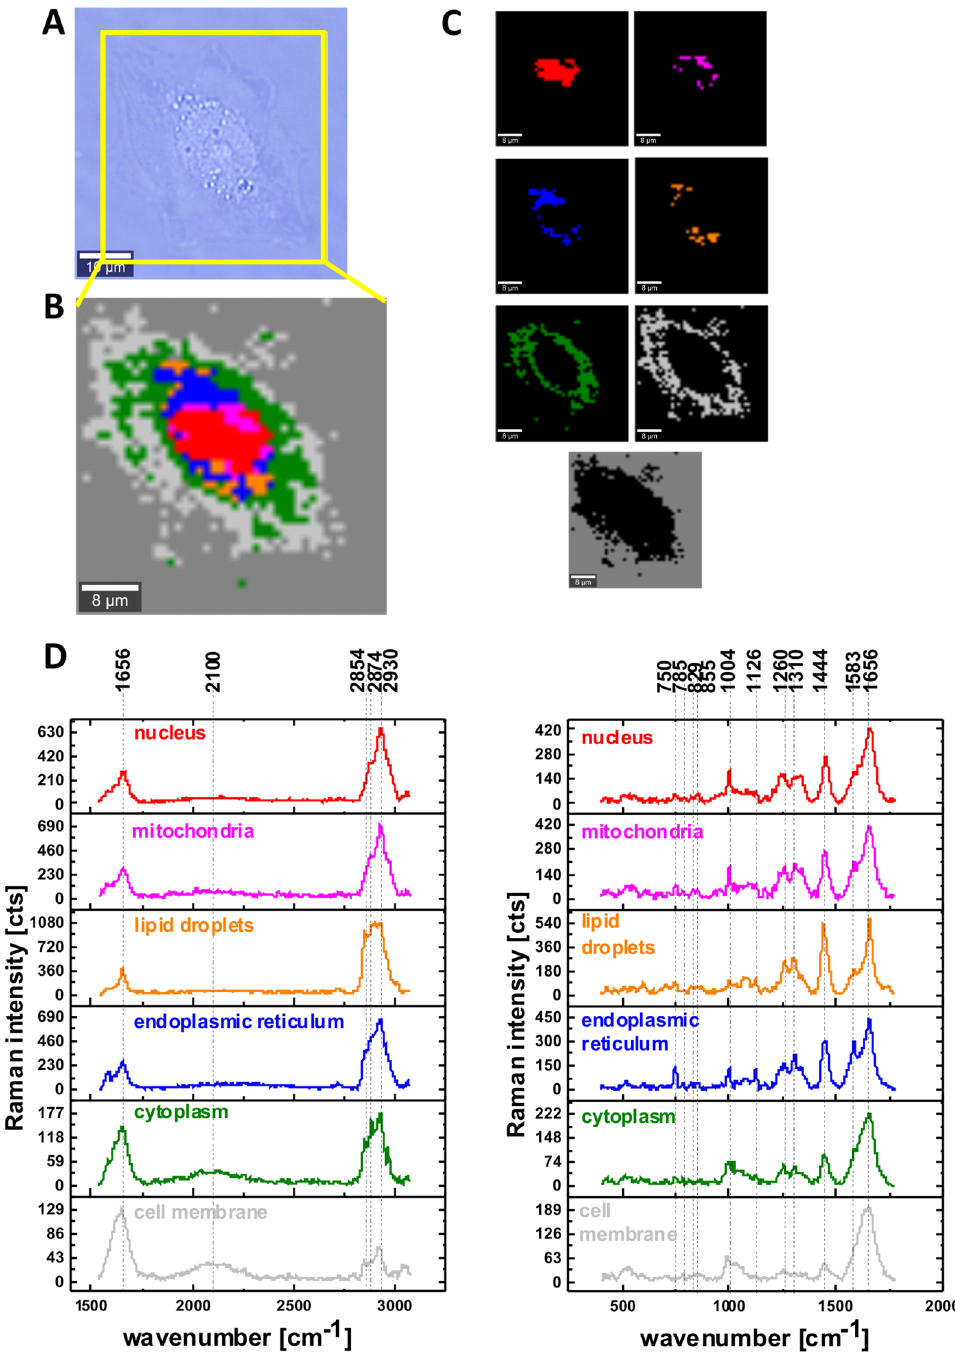
Figure 2. The microscopy image ( A ), Raman image for the area marked by yellow frame in the panel A, the size of Raman image (44 μm × 45 μm), resolution 1 μm of a typical human lung cell CCL-185 in hyperglycemia conditions supplemented with glucose 100 mM ( B ), Raman images of separate clusters identified by Cluster Analysis method assigned to: nucleus (red), mitochondria (magenta), endoplasmic reticulum (blue) and lipid droplets (orange), cytoplasm (green), cell membrane (light grey) and cell environment (dark grey) ( C ), the average Raman spectra for all clusters for high and for low frequency region ( D ) colors of the spectra correspond to the colors of clusters; integration time 0.3 s in the high frequency region and 0.5 s in the fingerprint region, laser power